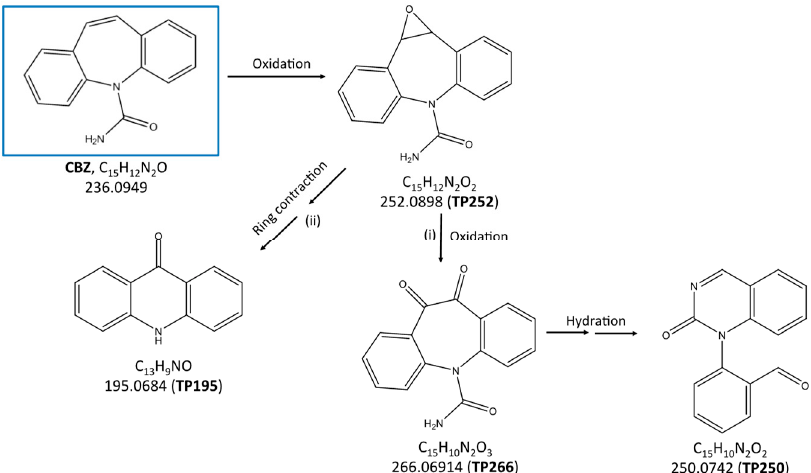
Figure 7. Proposed degradation pathway of carbamazepine degradation by conventional photocatalysis obtained on the basis of the identified TPs.